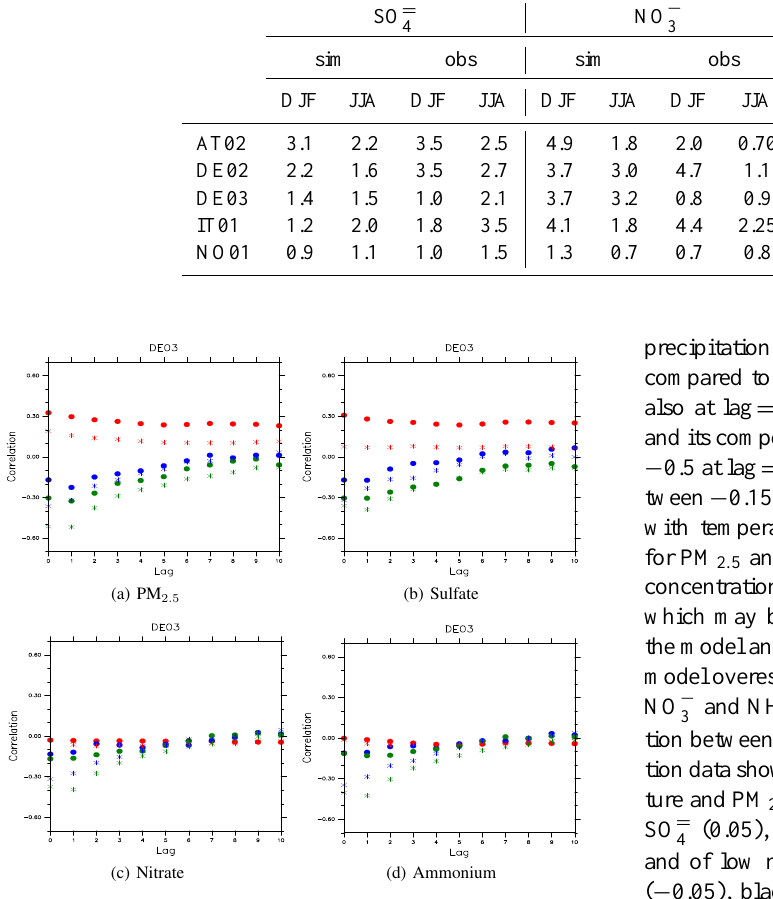
Fig. 7. Correlations between meteorology (temperature in red, pre- Fig. 7 : Correlations between meteorology (temperature in red, precipitation in blue, wind speed cipitation in blue, wind speed in green) on a given day and pollutant in green) on a given day and pollutant concentrations (PM 2 . 5 , sulfate, nitrate and ammonium), concentrations (PM 2 . 5 , sulfate, nitrate, and ammonium), ranging up ranging up to 10 days after at DE03 (2006-2008). Simulated data are represented with a star, to 10 days after at DE03 (2006–2008). Simulated data are repre- while observational data are represented with a dot. sented with a star, while observational data are represented with a dot.